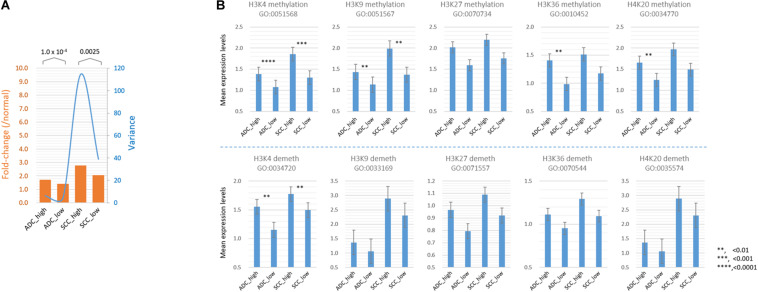
Comparison of the mean expression levels of genes in different histone modification categories between SETDB1-high and SETDB1-low samples in lung ADCs and SCCs. (A) The mean expression levels of genes (fold change; orange bars) and variance of the fold change values (blue line) in the histone modification category genes. (B) The mean expression levels of “HISTONE METHYLATION” and “HISTONE DEMETHYLATION” category genes. The gene ontology (GO) identification is indicated below each GO term. Asterisks indicate the significant differences at the denoted levels. The expression levels of individual genes were normalized to the mean expression levels of normal samples. A significant difference (paired sample t-test) was observed between the SETDB1-high and SETDB1-low samples of ADCs and SCCs.